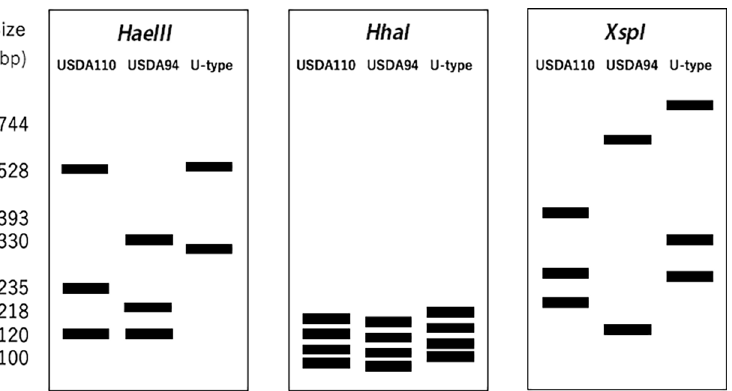
Fig 1. Schematic representation of amplicon patterns based on PCR-RFLP analysis of the l6S-23S rDNA internal transcribed spacer region of B . japonicum USDA110, B . elkanii USDA94, and Bradyrhizobium sp . (unidentified species).